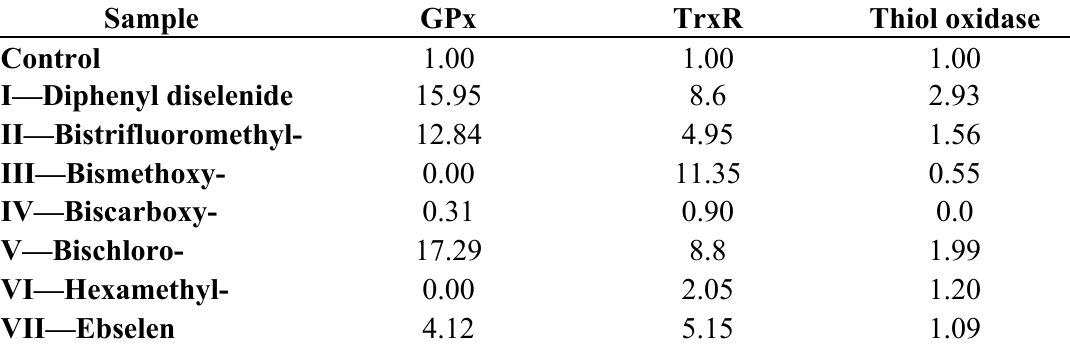
Table 2. Comparisons of the relative activities (GPx, TrxR and Thiol oxidase) of organoseleno